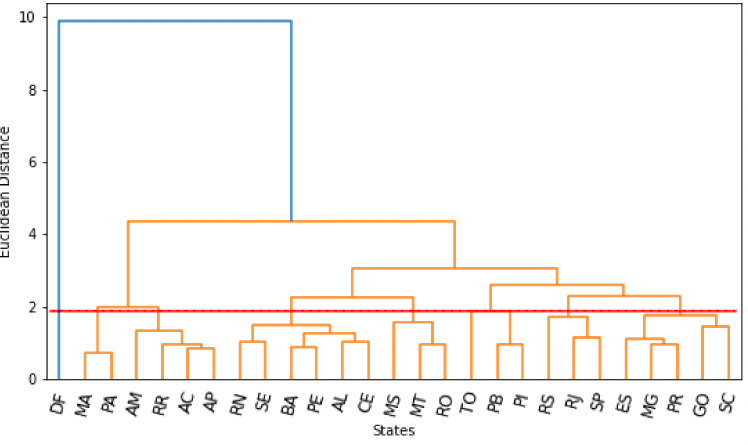
Figure 5. Dendrogram generated with data of the elderly 64 years or older. The multivariate analysis technique was applied to the 2021 data, grouping Brazil in a different format from the Brazilian regions, which can be observed in the branches of the tree. It presents satisfactory CCC (0.889), and eight clusters were suggested.